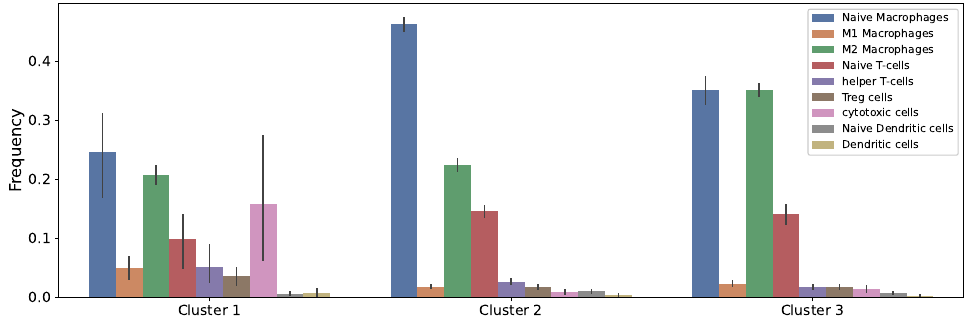
Figure 2. Estimated immune infiltrates in each cluster. Clusters were derived according to varia- tions in 22 immune cell types of osteosarcoma